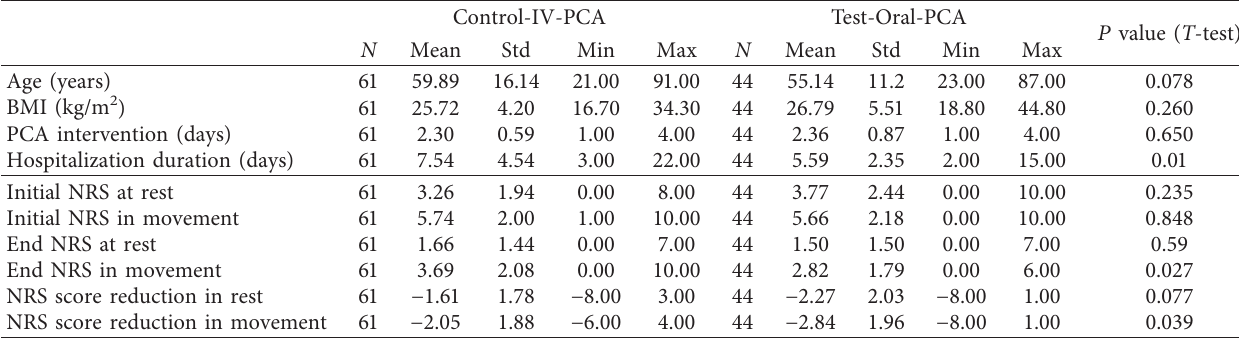
Table 2: Cross-cohort comparison of patients’ continuous variables by T -test for independent samples.